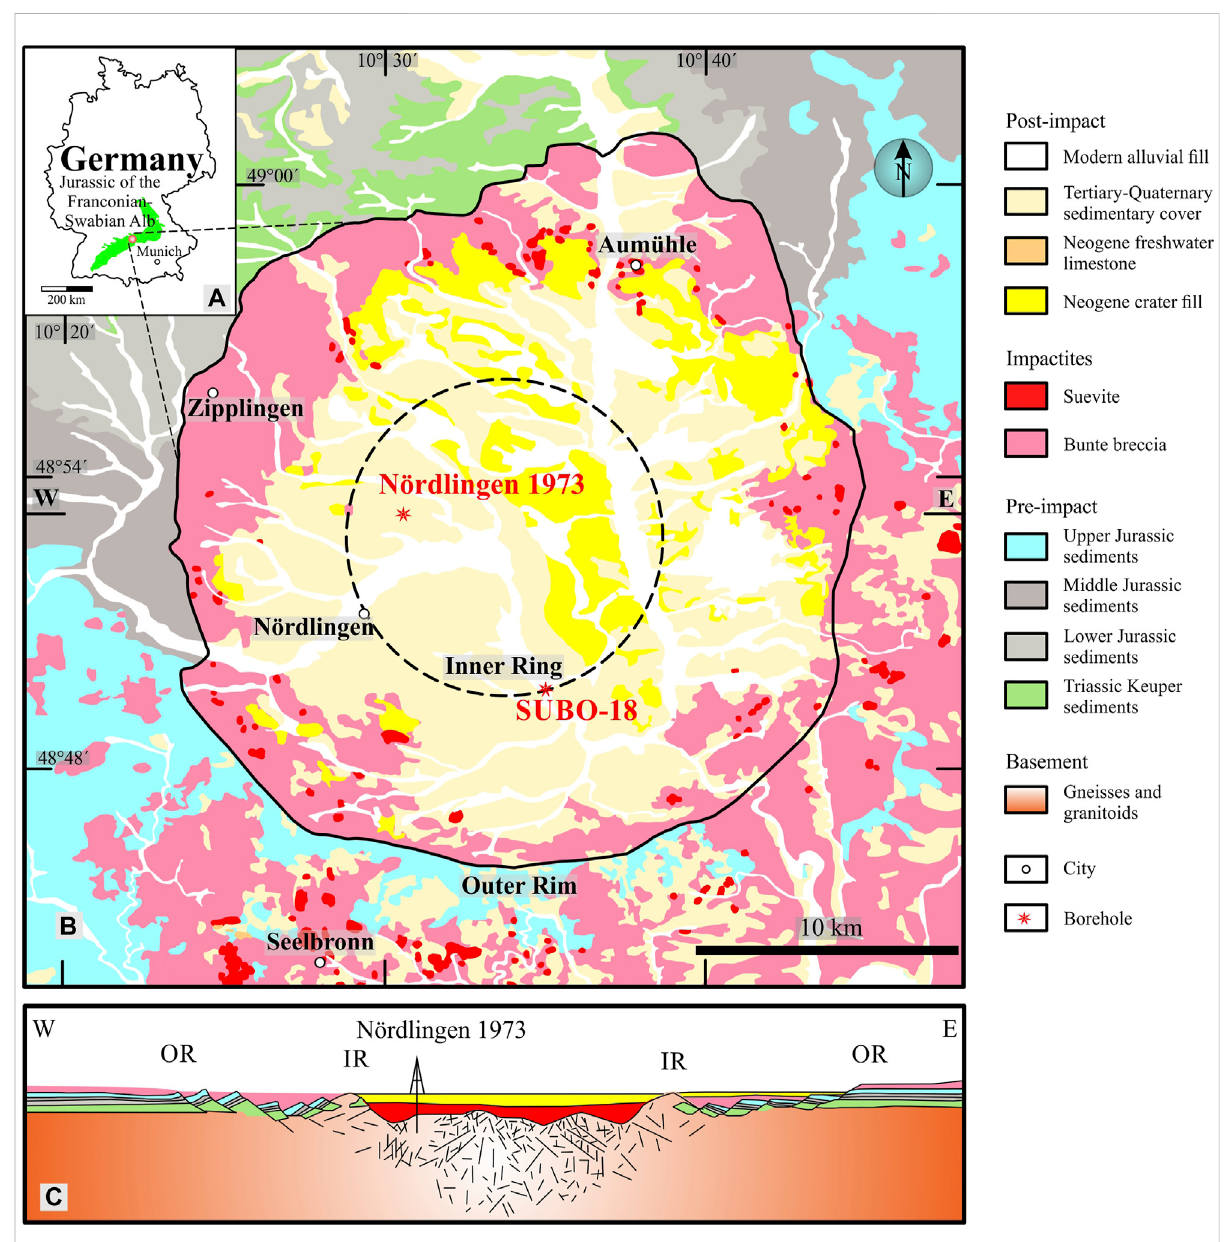
FIGURE 1 Geological map of the study area in (A) southern Germany showing (B) the Nördlinger Ries impact crater with the drilling location NR-1973 (central crater) and SUBO-18 (marginal crater) relative to the inner ring (modi fi ed after Erickson et al., 2017), as well as (C) an east-west seismic cross section of the